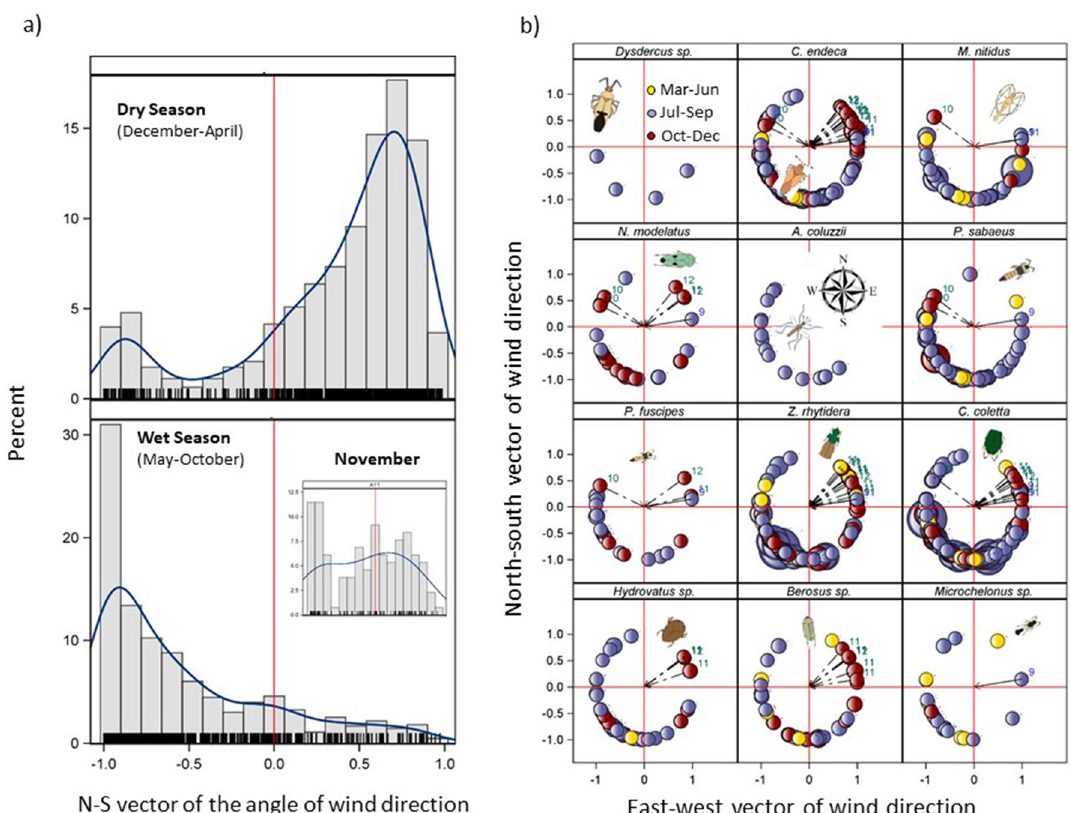
Figure 5. Seasonality of the south-north component of nightly wind direction in the Sahel and nightly wind direction during high-altitude flights of each taxon. ( a ) To explore the possibility of north–south migration into the Sahel from more equatorial regions, the north–south component of nightly wind direction (2012–2015 MERRA2 data; all nights) shows the frequencies of winds during the dry (top) and wet (bottom) season in Thierola (the other villages exhibited similar distributions). Kernel distributions are shown in blue. Wind direction from the N and S are indicated by positive and negative south–north vector values, respectively. INSET: November is a transition month with variable wind direction. Red reference line at the origin indicates easterly or westerly winds. Fringe marks indicate actual values south-north component of wind direction. ( b ) Wind direction during high-altitude flights of selected taxa. Circles denote source of mean nightly winds in relation to the capture location (origin) with north and east denoted by top and right red lines, respectively. Circle size reflects nightly aerial density and their color denotes the period (top left). Dotted arrows highlight southbound winds during the end of the wet season, that could be used for the “return” migration from the Sahel towards tropical areas closer to the Equator (numbers denote the months of such events). Schematic insect silhouettes are not to